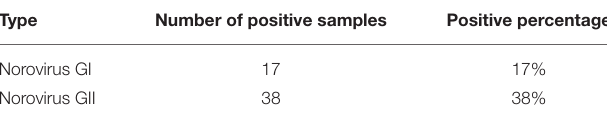
TABLE 3 | Detection of NoV in human diarrhea